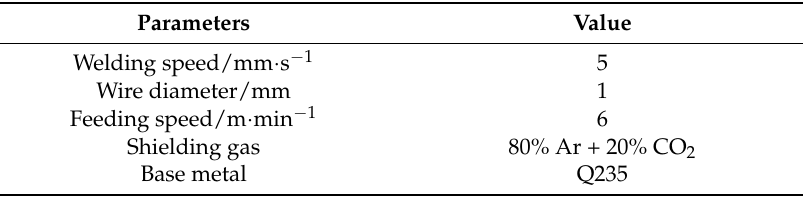
Table 2. Experiment parameters.